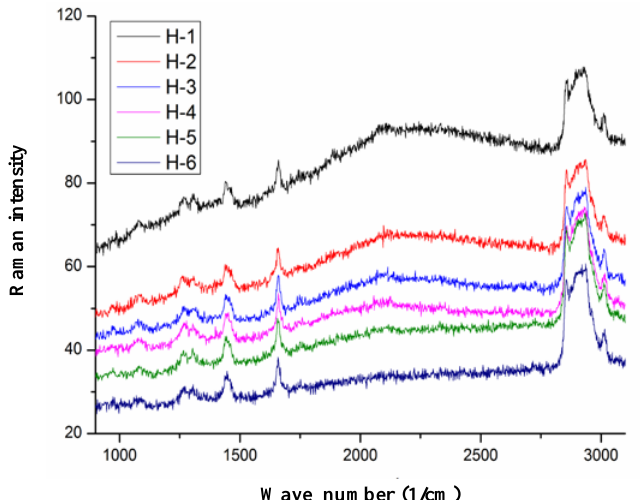
Figure 3. Raman image of high-pressure homogenous preparation of nanoemulsions.